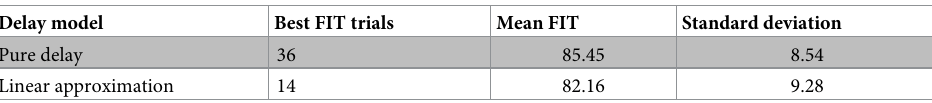
Table 4. Comparison of pure delay and linear approximation.